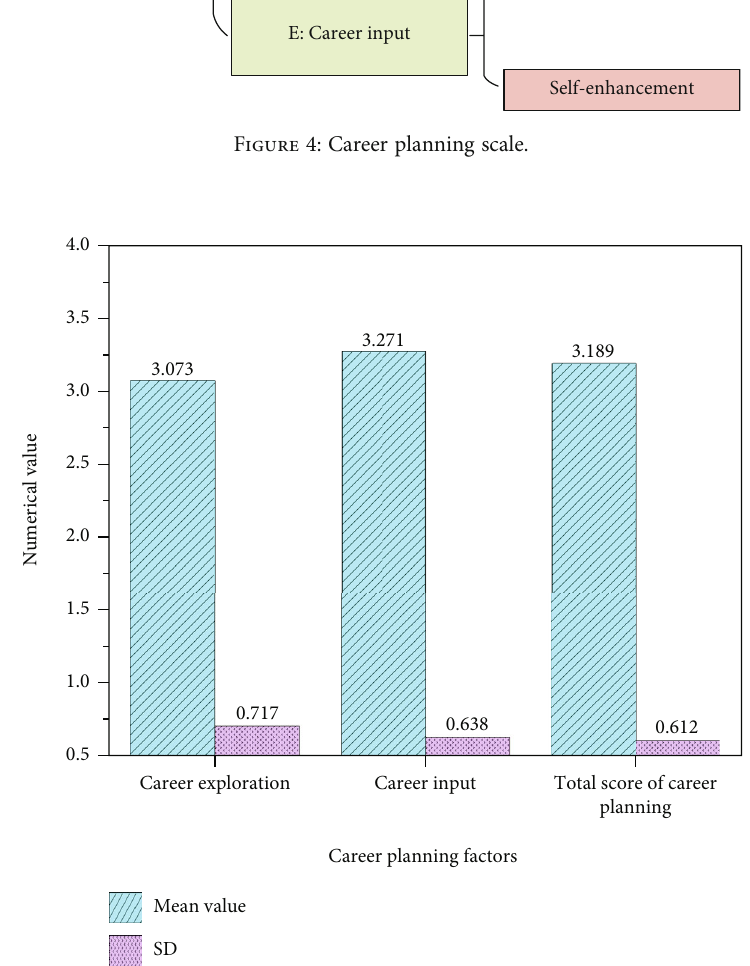
Figure 5: Descriptive statistics of career planning and various